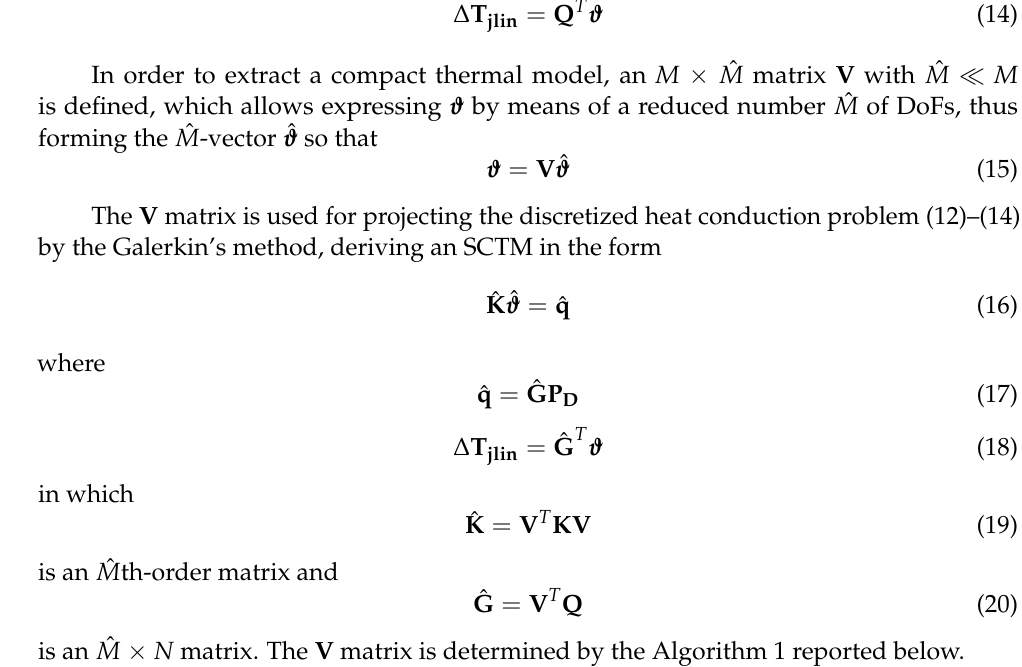
Algorithm 1: SCTM